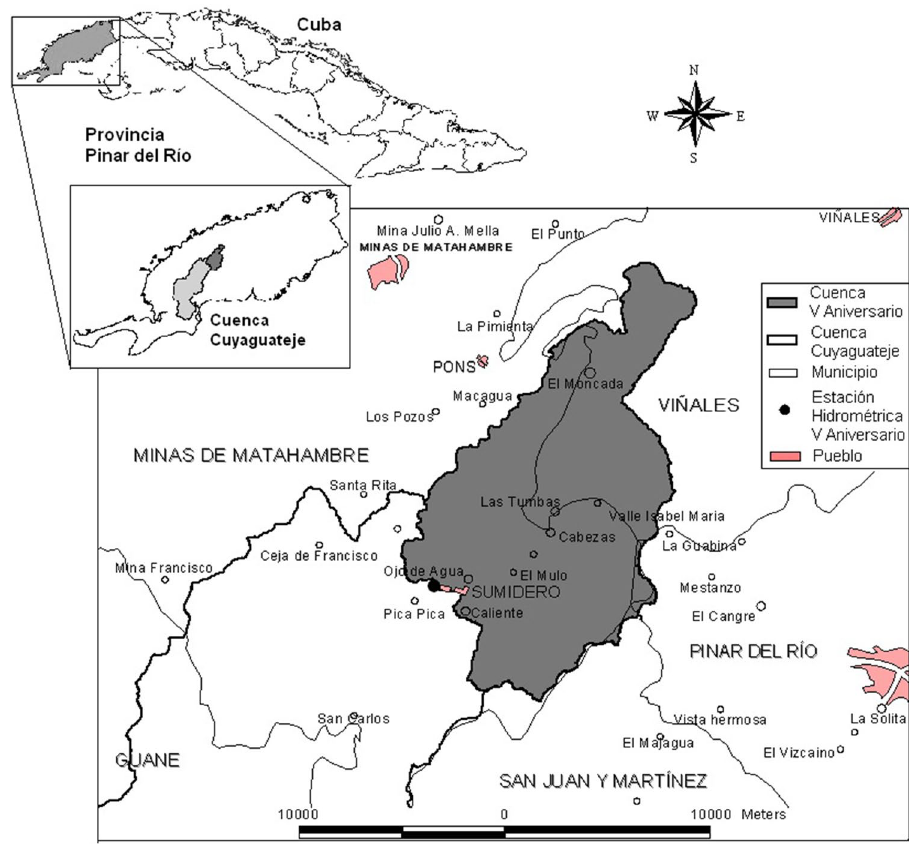
Fig. 1 Geographical location of V Aniversario